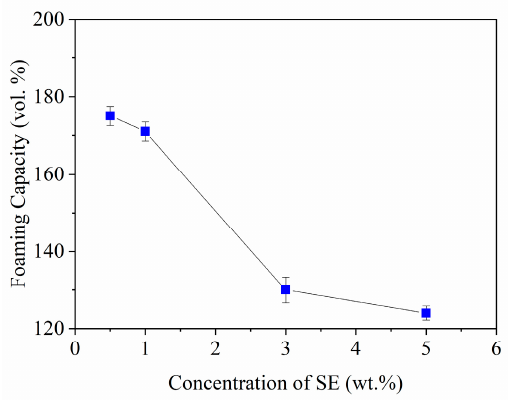
Figure 4. Foaming capacity of the ceramic slurries as function of SE content.